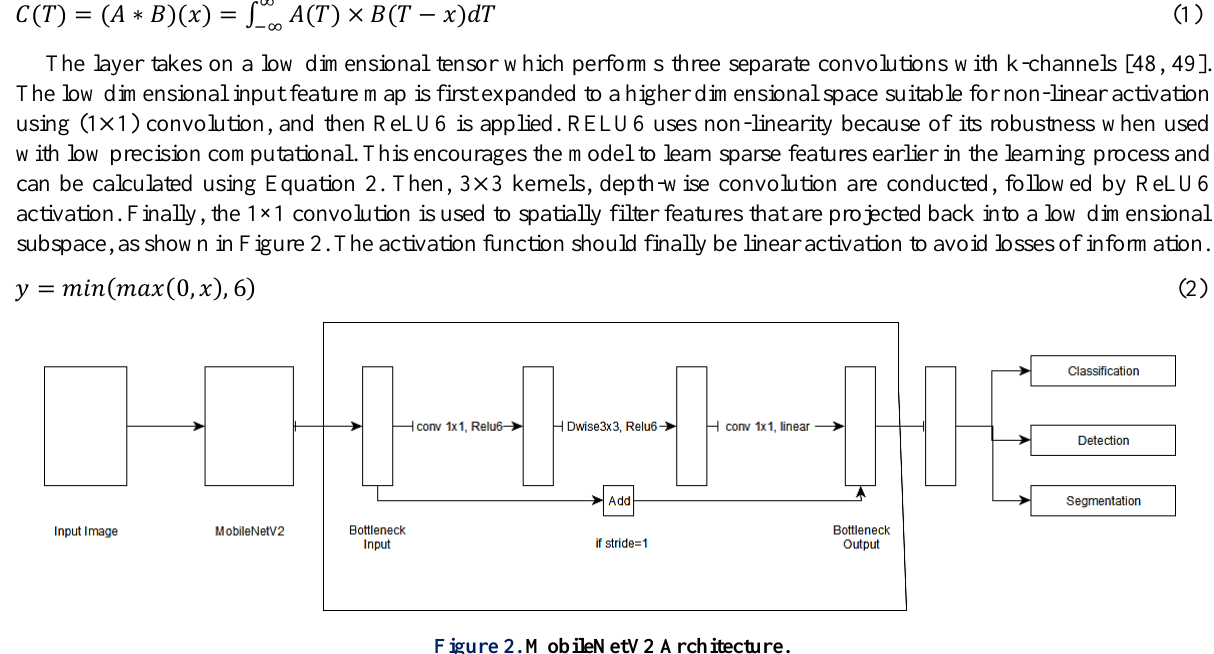
Figure 2. MobileNetV2 Architecture.